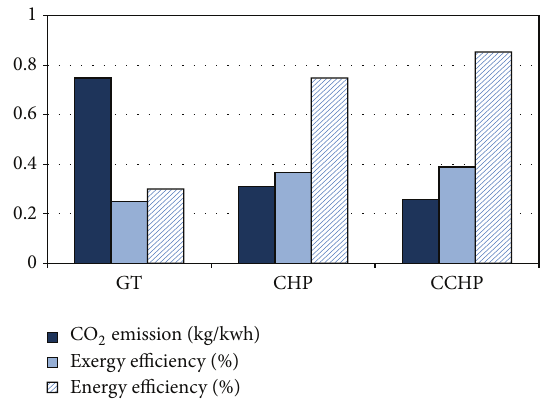
Figure 2: Energy efficiency, exergy efficiency, and normalized CO 2 emission for CCHP, CHP, and gas turbine cycles.